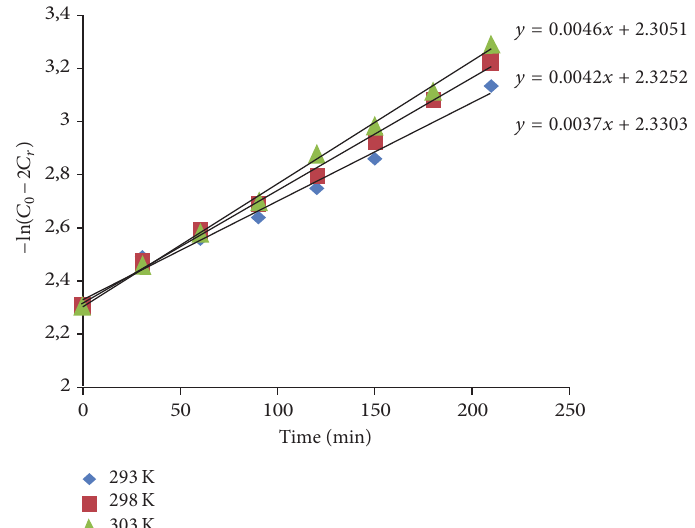
Figure10: − ln (𝐶 0 −2𝐶 𝑟 ) termevolutionversustemperatureforthefacilitatedextractionofVO 2+ ionsthroughmembraneSLM-TOA.[H 3 O + ] = 1M, [TOA] = 10 −2 M, [VO 2+ ] = 0.1 M.